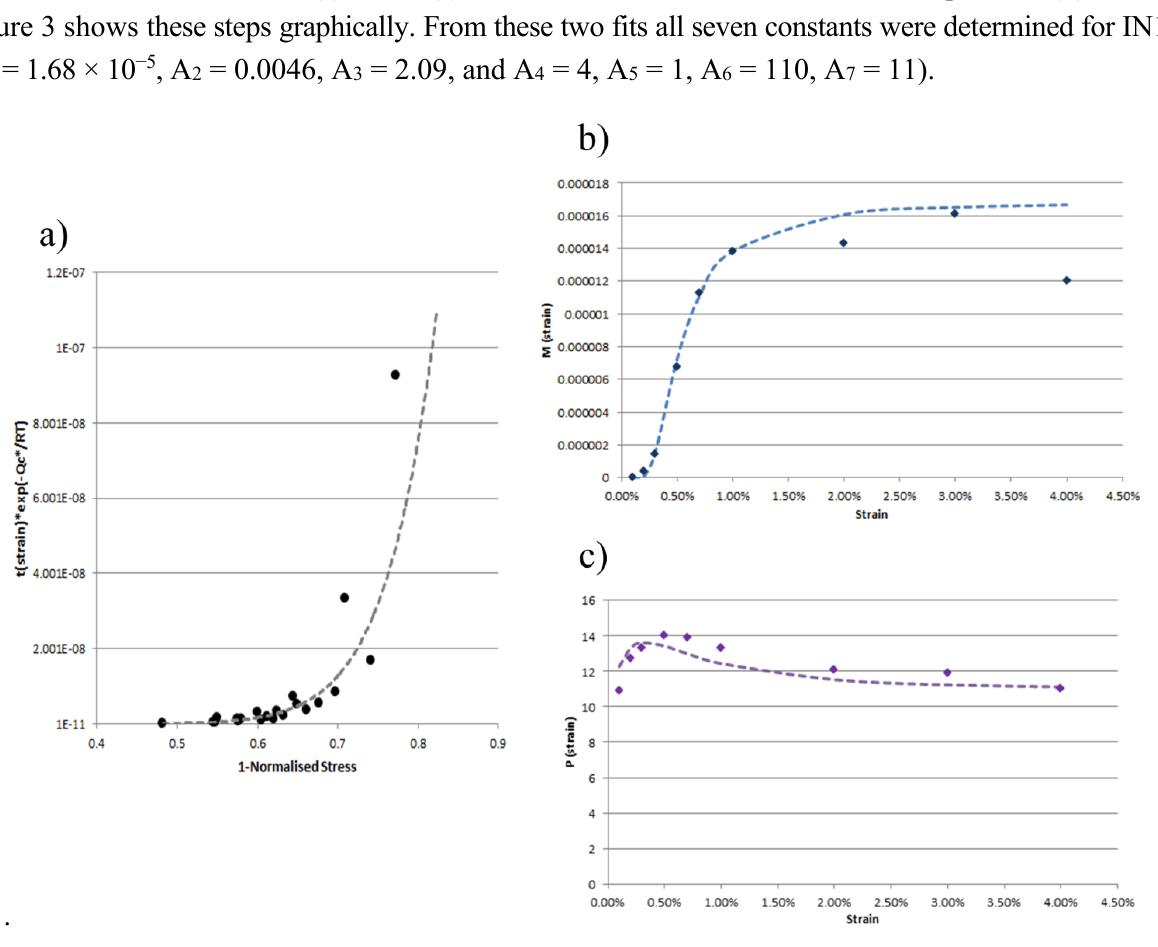
Figure 3. Determination of model constants: ( a ) t( ε )exp( − Q c* /RT) vs. (1 − σ / σ N ) fitted with function of form y = Mx P (dotted line) for a given strain; ( b ) coefficient M( ε ) vs. ε fitted with function in Equation (5) (dotted line); ( c ) coefficient P( ε ) vs. ε fitted with function in Equation (6) (dotted